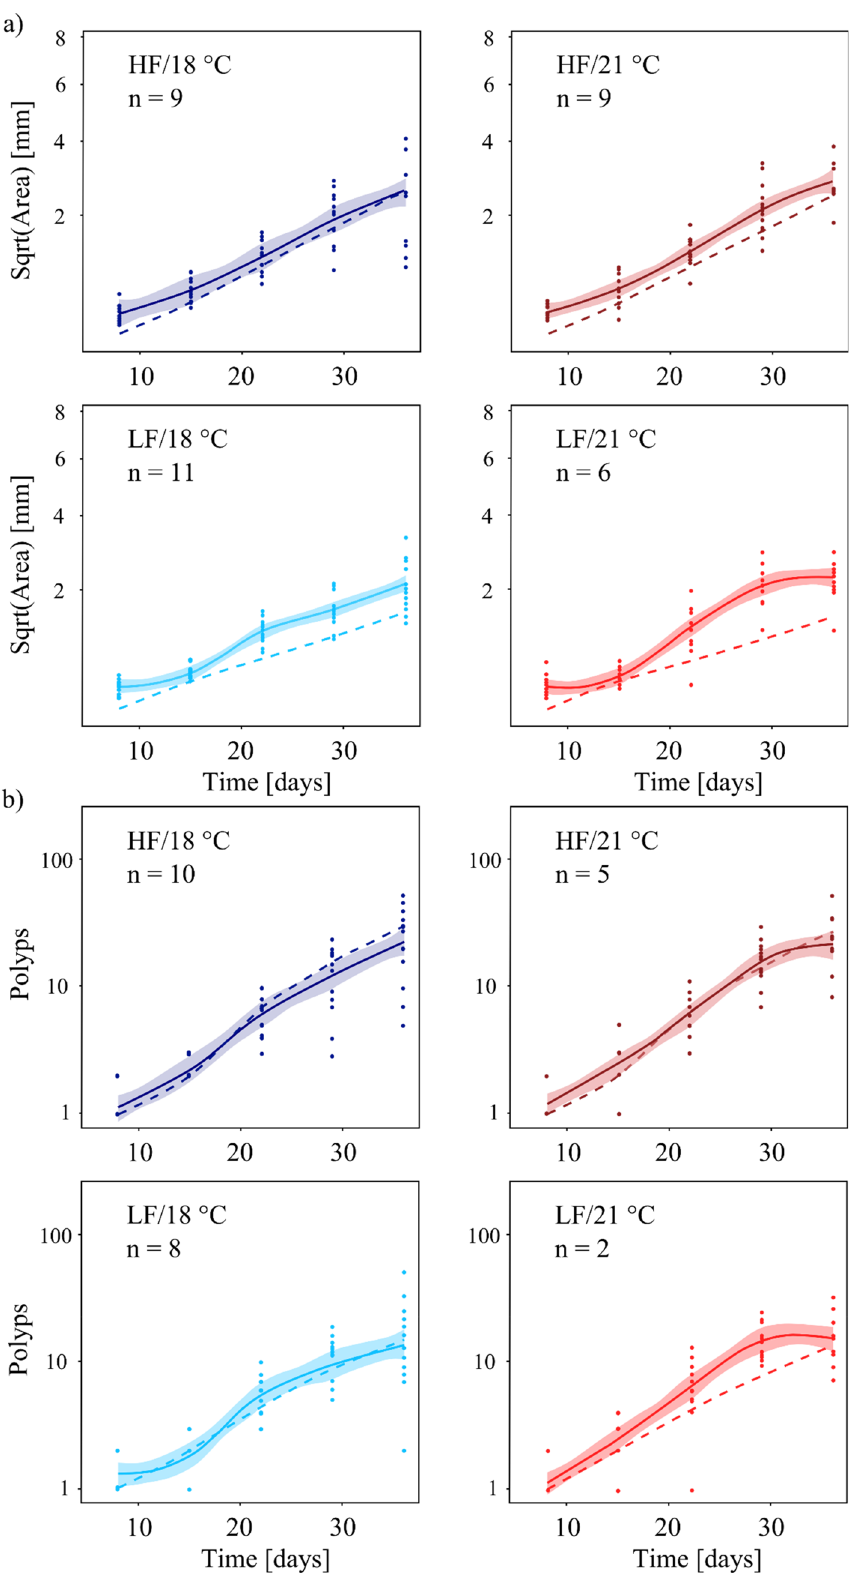
Figure 5. Area ( a ) and polyp number ( b ) of H. echinata juveniles in scenario 2 over a period of five weeks post-settlement (median ± SE; solid line and shaded region) compared to numerical growth model data (dashed lines). HF = high food (dark blue and red lines); LF = low food (light blue and red lines); 18 °C = control temperature (blue line); 21 °C = high-temperature (red lines). All treatments contained an extra temperature step of + 1.5 °C for six hours daily (see also Fig.